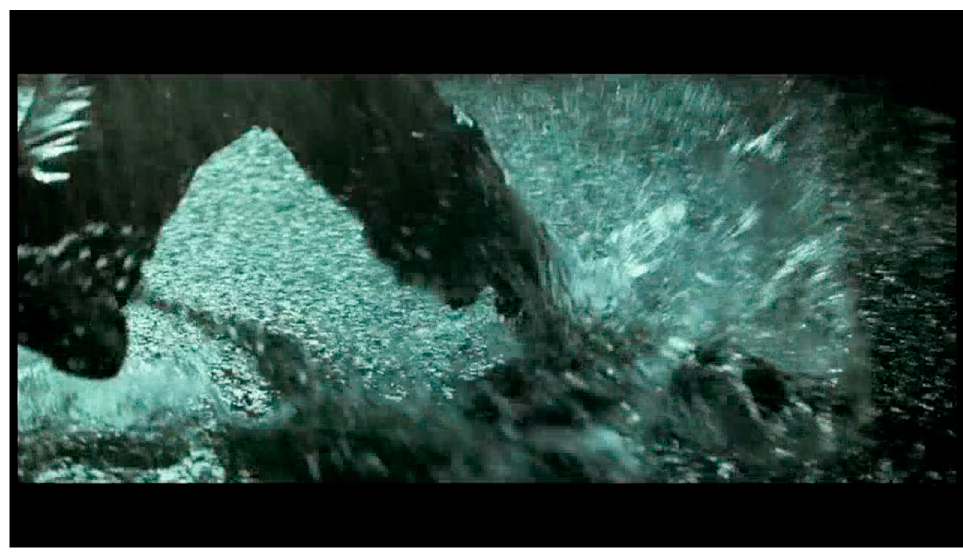
Figure 18. What moves across both figure and ground is power/energy/qi. Frame capture, The Grandmaster (Wong 2013). Arts 2017 , 6 , 19